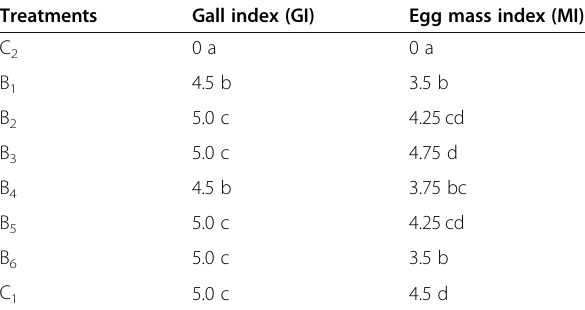
Table 4 Mean comparison of gall and egg mass indices in greenhouse experiment